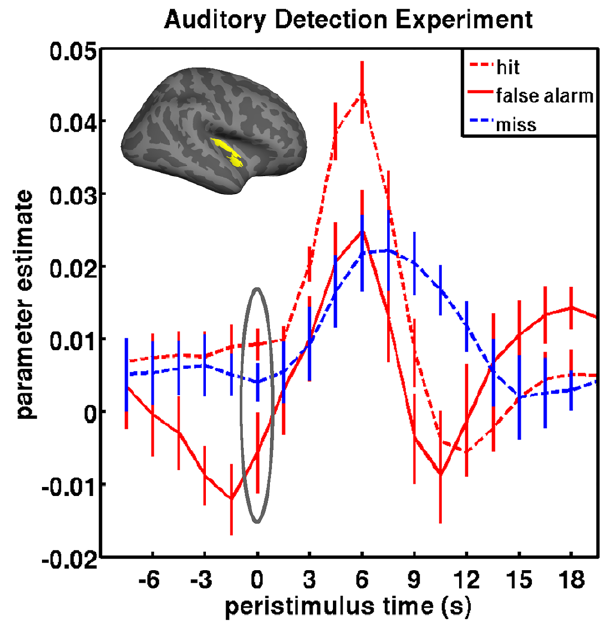
Figure 2. Peristimulus fMRI signal time-courses from the auditory experiment. Data were estimated under a finite response model and averaged across 9 subjects (bars represent standard error of the mean) performing an auditory stimulus detection task. Data are plotted for conditionsspecified byan insert. The inflated righthemisphere rendering of the group result shows the location of the region of interest, which includes early auditory cortex with parts of Heschl’s gyrus (identified bilaterally subject by subject). The grey ellipse covers the pre-stimulus period submitted to statistical testing (see main text).